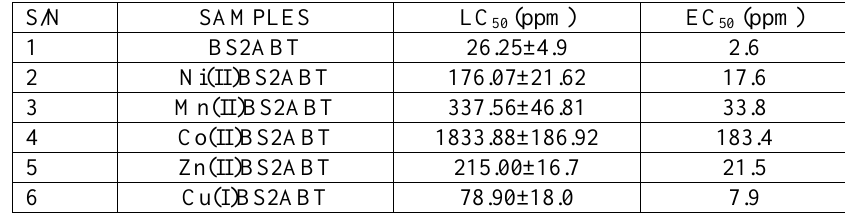
Table 7. Lethal Concentration (LC ) and Effective Concentration 50 (EC ) Results in ppm (Cytotoxic 50